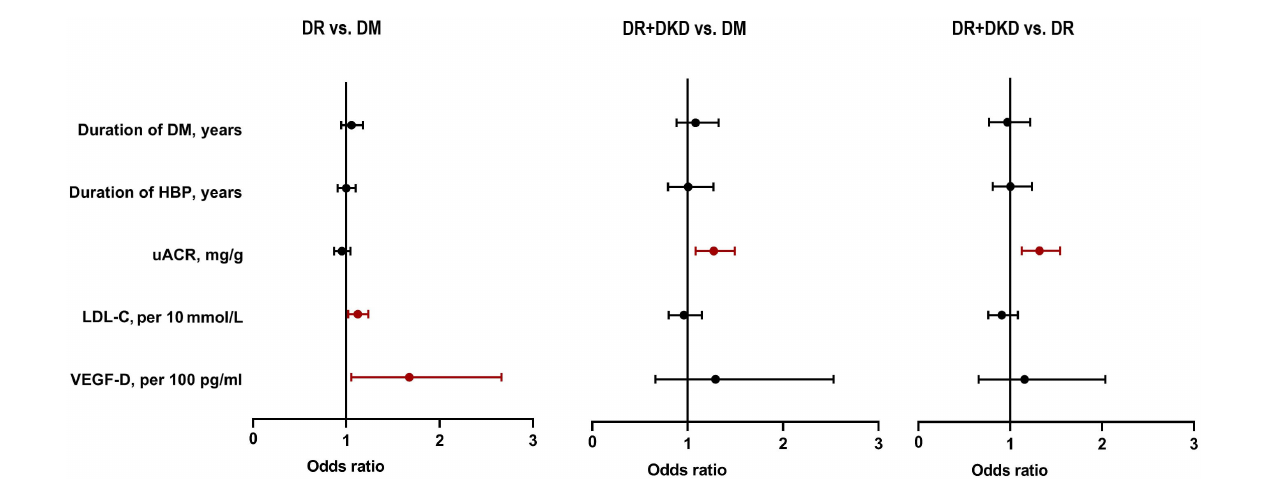
FIGURE3 Multivariate logistic regression analysis showing uACR, LDL-C, and VEGF-D were risk factors for DR and DKD. DM, diabetes mellitus; DR, diabetic retinopathy; DKD, diabetic kidney disease; HBP, high blood pressure; LDL-C, low-density lipoprotein cholesterol; uACR, urinary albumin/creatinine ratio; VEGF, vascular endothelial growth.